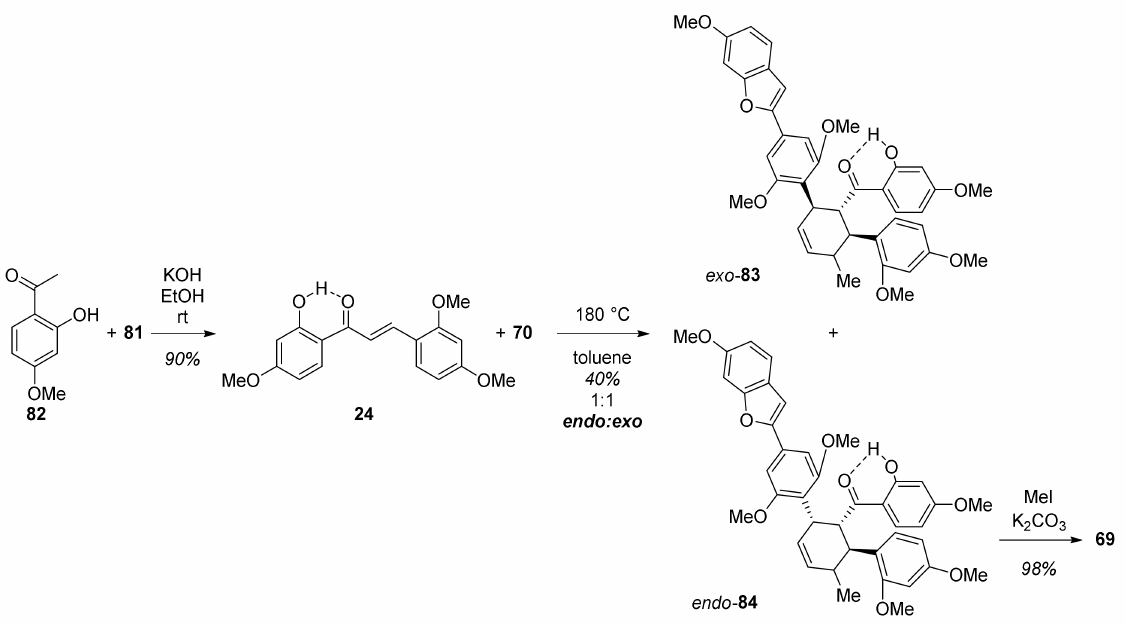
Figure 24. Diels–Alder reaction between 70 and phenolic chalcone 24